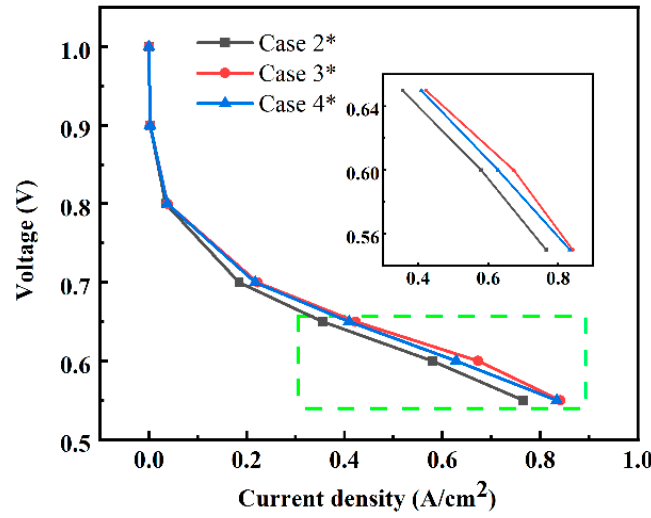
Figure 14. Comparison of the polarization curves in Case 2*, Case 3* and Case 4*.